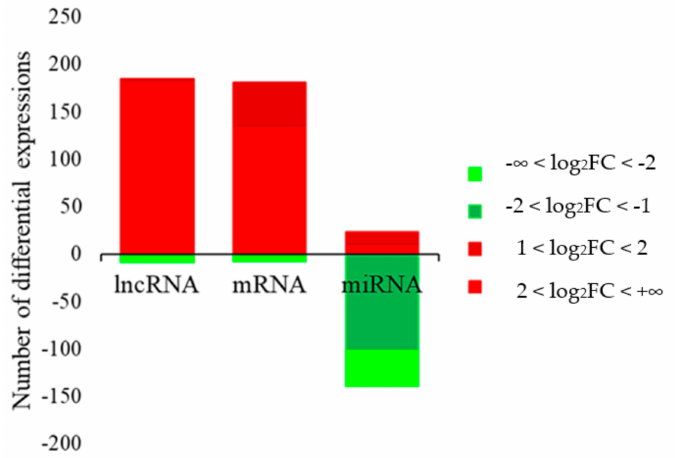
Figure 4. Differentially expressed lncRNAs, mRNAs and miRNAs in skin. Differential expression is shown as log 2 fold change (FC). RNAs that are relatively more abundant in white skin are shown using red and those that are relatively less abundant are shown in green. Color intensity represents FC